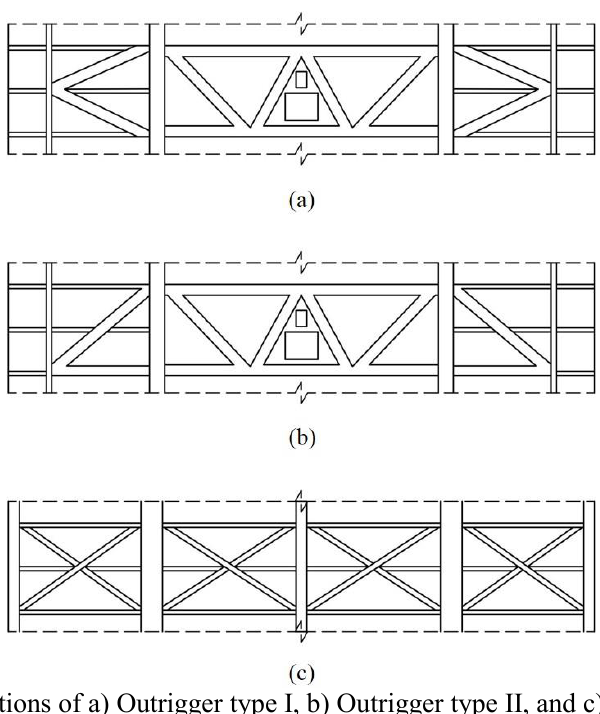
Fig. 4. Sections of a) Outrigger type I, b) Outrigger type II, and c) Belt truss.